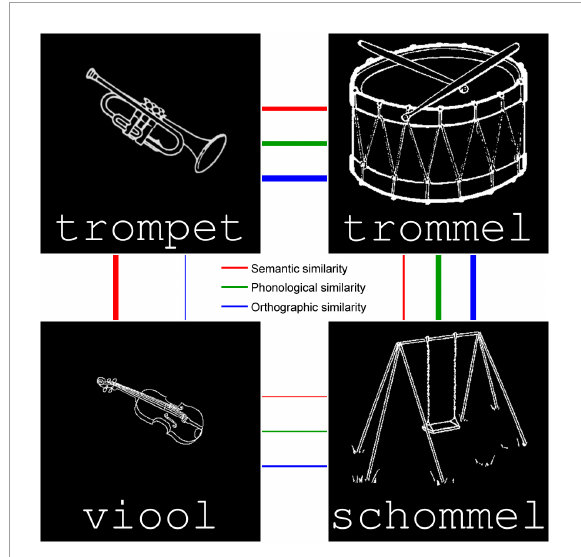
FIGURE1 Four example stimuli, showing both the drawn image and typed word (semantics and orthography, respectively). Auditory versions of the spoken word are played when the stimulus is clicked or dragged, to activate phonology. The thickness of the arrows indicates semantic, orthographic, and phonological similarity between items (thicker arrows refer to more similar